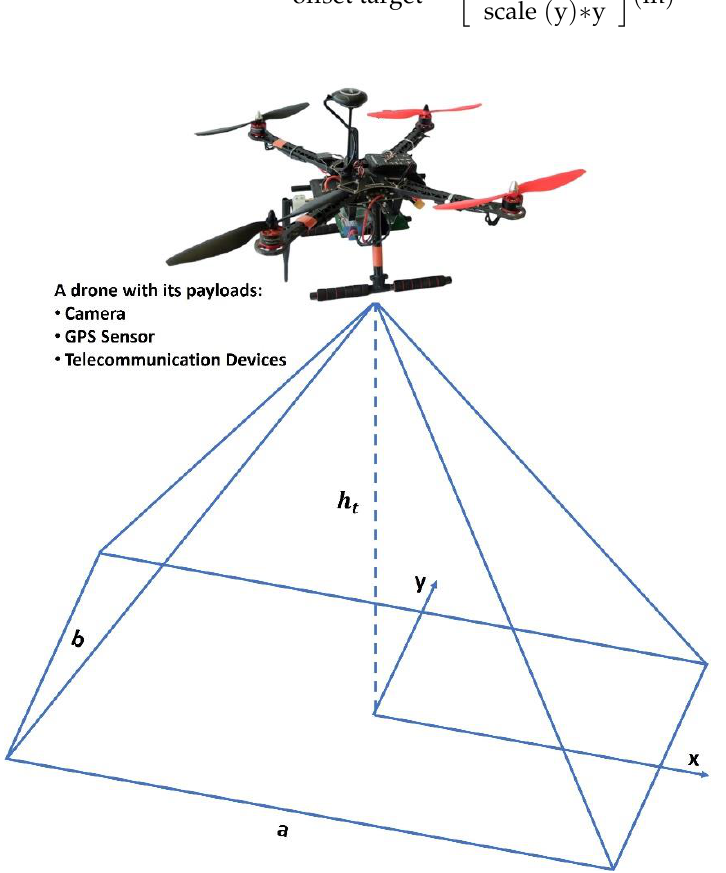
Figure 5. A drone with a bride’s eye view of the vertical coordinates of GPS positions. As the GPS location of the image frame is referenced from the centre of the image, the GPS must be corrected. In this way, missing persons on the edges of the frame can be located more accurately. The pixel values are given to the software in x and y Cartesian coordinates, then multiplied by the distance per pixel in their respective directions. The x and y directions are then rotated depending on the heading of the drone using the rotation of matrix, as per (17):